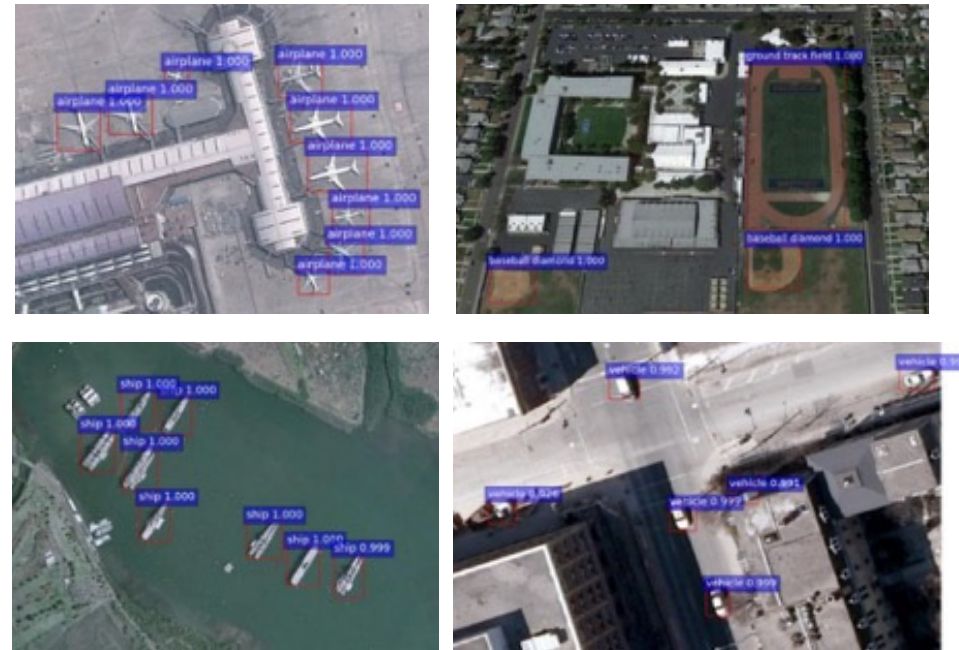
Figure 4. The results of some detected objects from NWPU VHR10.